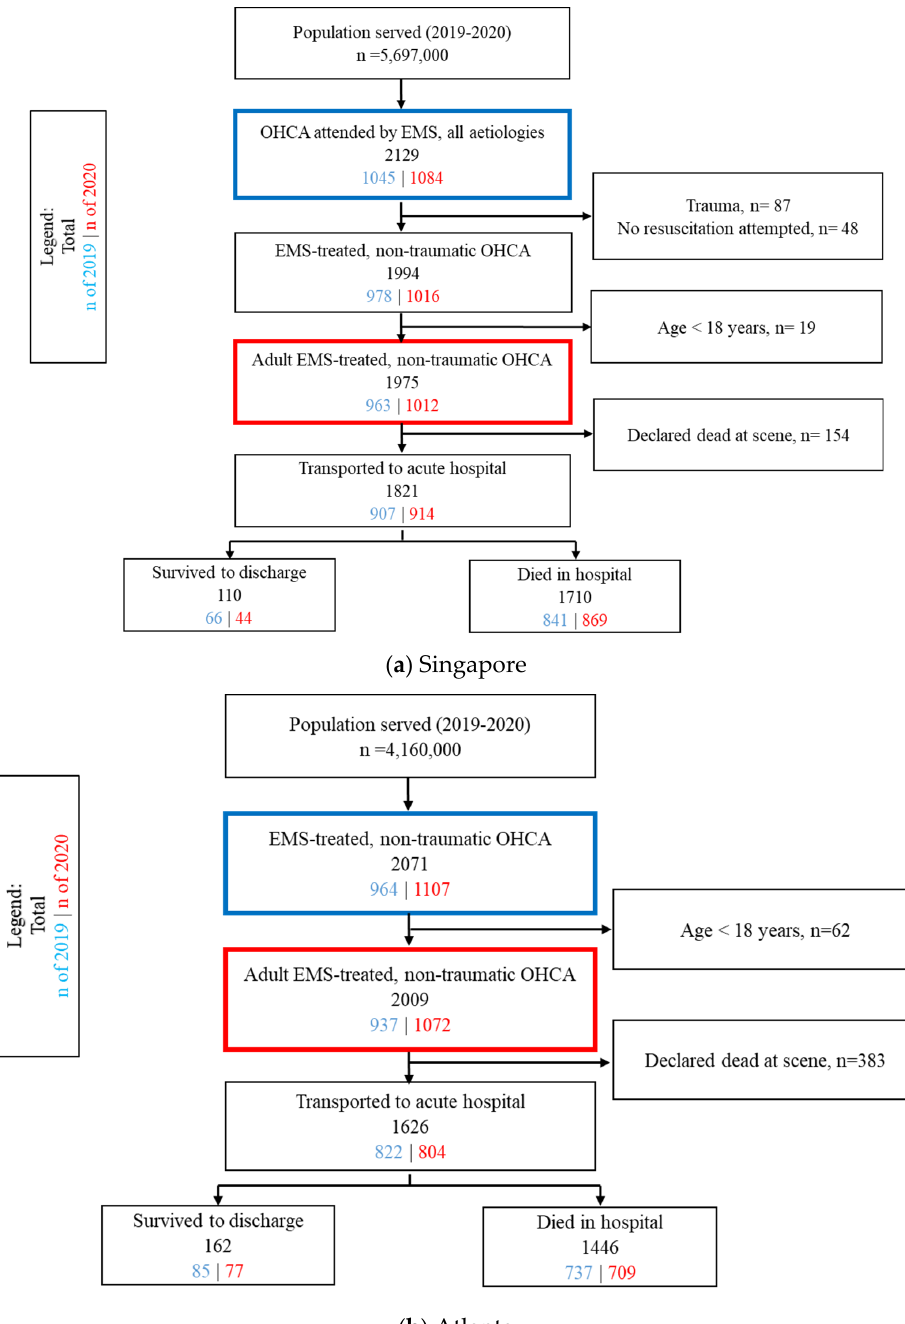
Figure 1. Flowchart of patient selection in Singapore and Atlanta. Patient selection during the pandemic (17 weeks from date of first confirmed COVID-19 case in 2020) and pre-pandemic (corresponding dates in 2019) periods. For ( a ) Singapore, the date of the first confirmed case was 23 January 2020, and ( b ) Atlanta, the date of the first confirmed case was 2 March 2020. The blue box indicates OHCA patients captured by the respective registries; the red box indicates the final study population. Outcome (survival) data were not available for 1 patient in Singapore and 18 patients in Atlanta. Abbreviations: OHCA, out-of-hospital cardiac arrest; EMS, Emergency Medical Services; ROSC, return of spontaneous circulation; COVID-19, coronavirus disease 2019.